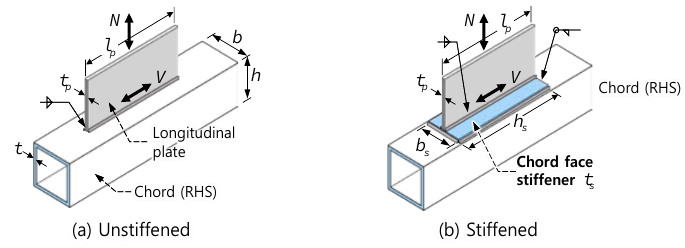
Figure 2. Details of longitudinal plate-to- rectangular hollow section (RHS) connections: ( a ) Unstiffened; ( b ) Stiffened.